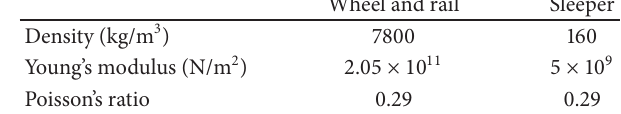
Table 1: Material properties of wheel, rail, and sleeper. Wheel and rail